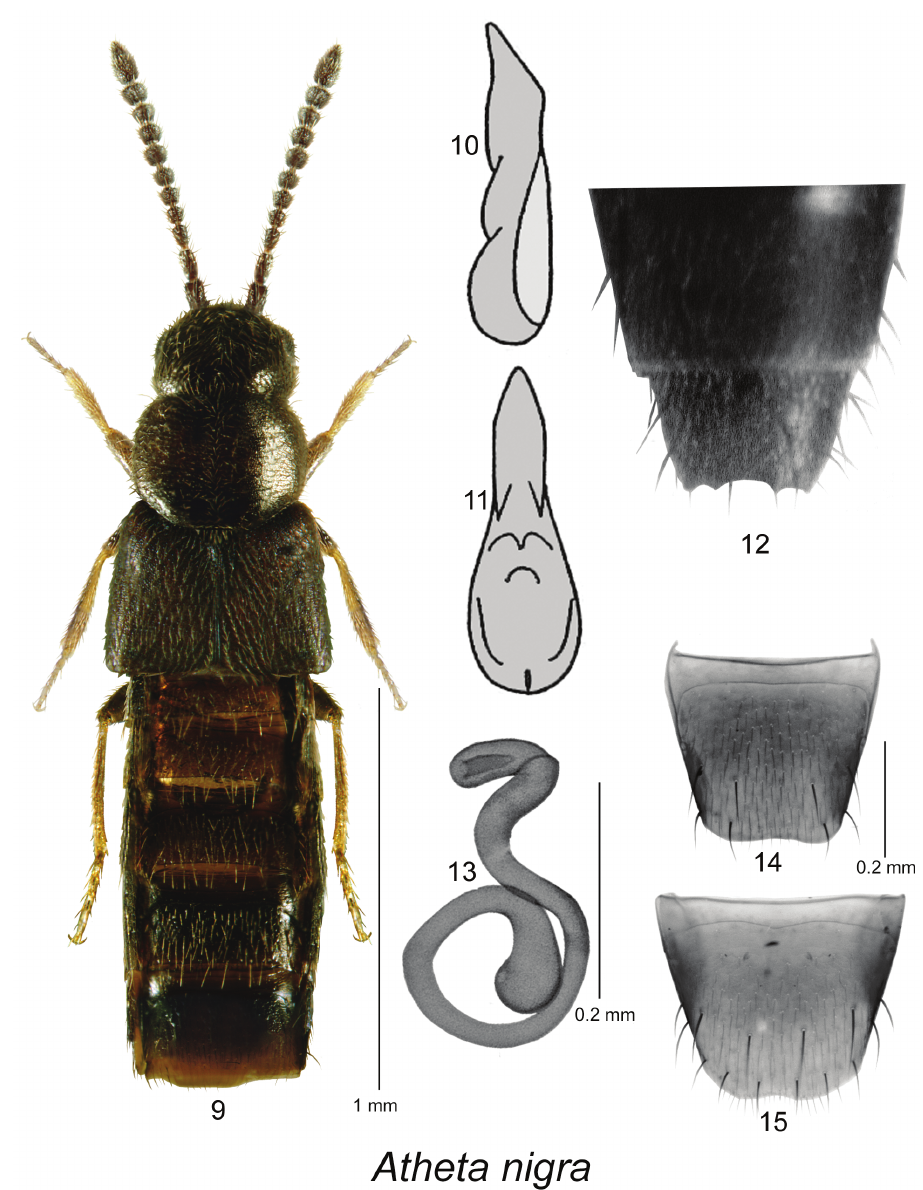
Figures 9–15. Atheta ( Datomicra ) nigra (Kraatz): 9 habitus in dorsal view 10 median lobe of aedeagus in lateral view, and 11 in ventral view 12 apical part of male abdomen with visible 4 dents on apical margin of male tergite VIII 13 spermatheca 14 female tergite VIII 15 female sternite VIII; 9, 13–15 based on a female from Saskatchewan 10, 11 after Benick and Lohse (1974) 12 based on a male from